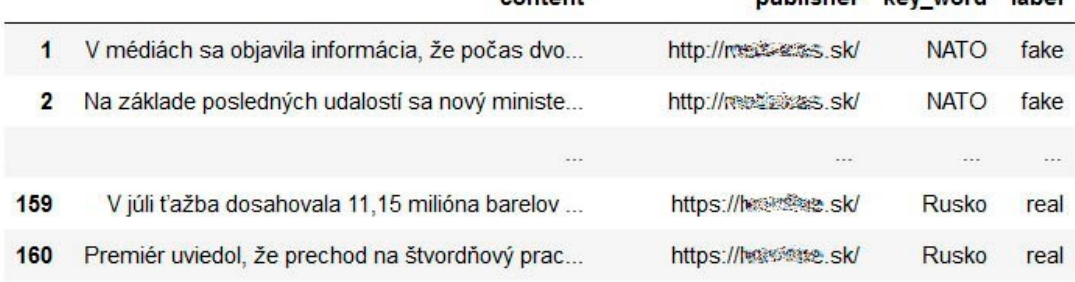
Table 1. Morphological division of the parts of speech of the explored dataset. Noun Pronoun Position Possible Values Description Possible Values Description